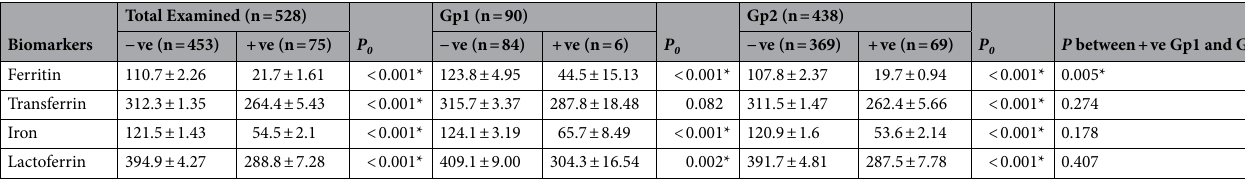
Table 6. Giardia lamblia in relation to some biomarkers and their effects on swimmers’ performance. Gp Group, − ve negative, + ve positive. Data were expressed using Mean ± Standard Error. p 0 : p-value for Mann– Whitney test for comparing Negative and Positive. p: p-value for Mann–Whitney test for comparing Positive cases of Gp1and Gp2. *Statistically significant at p ≤ 0.05.